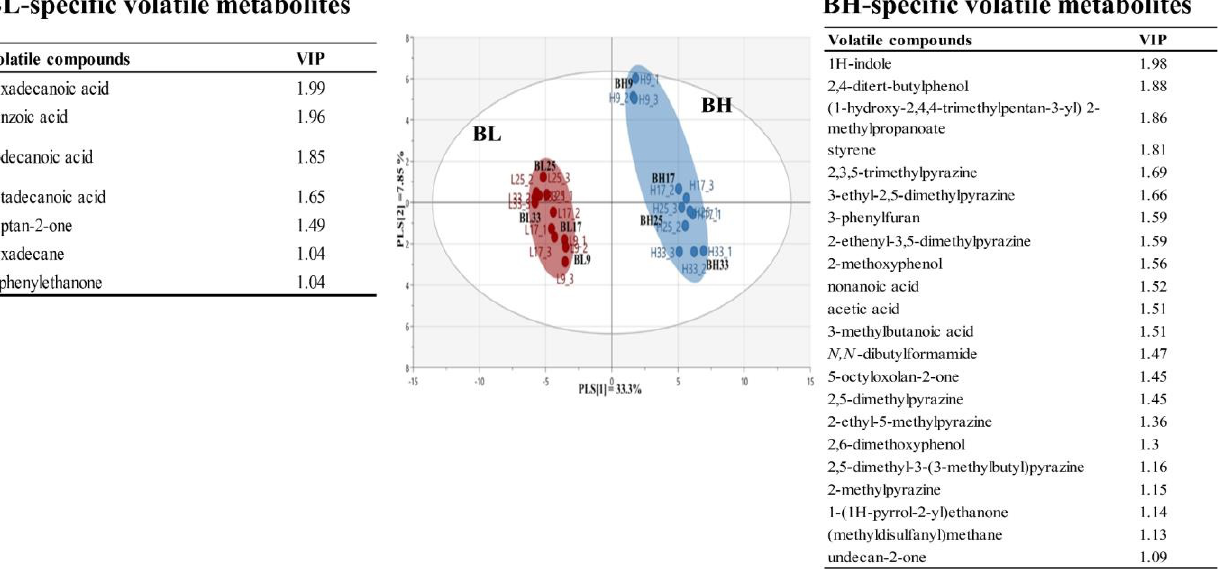
Figure 2. Multivariate statistical model by PLS-DA score plot based on volatile metabolite profiles, and the list of main variables representing BH or BL.